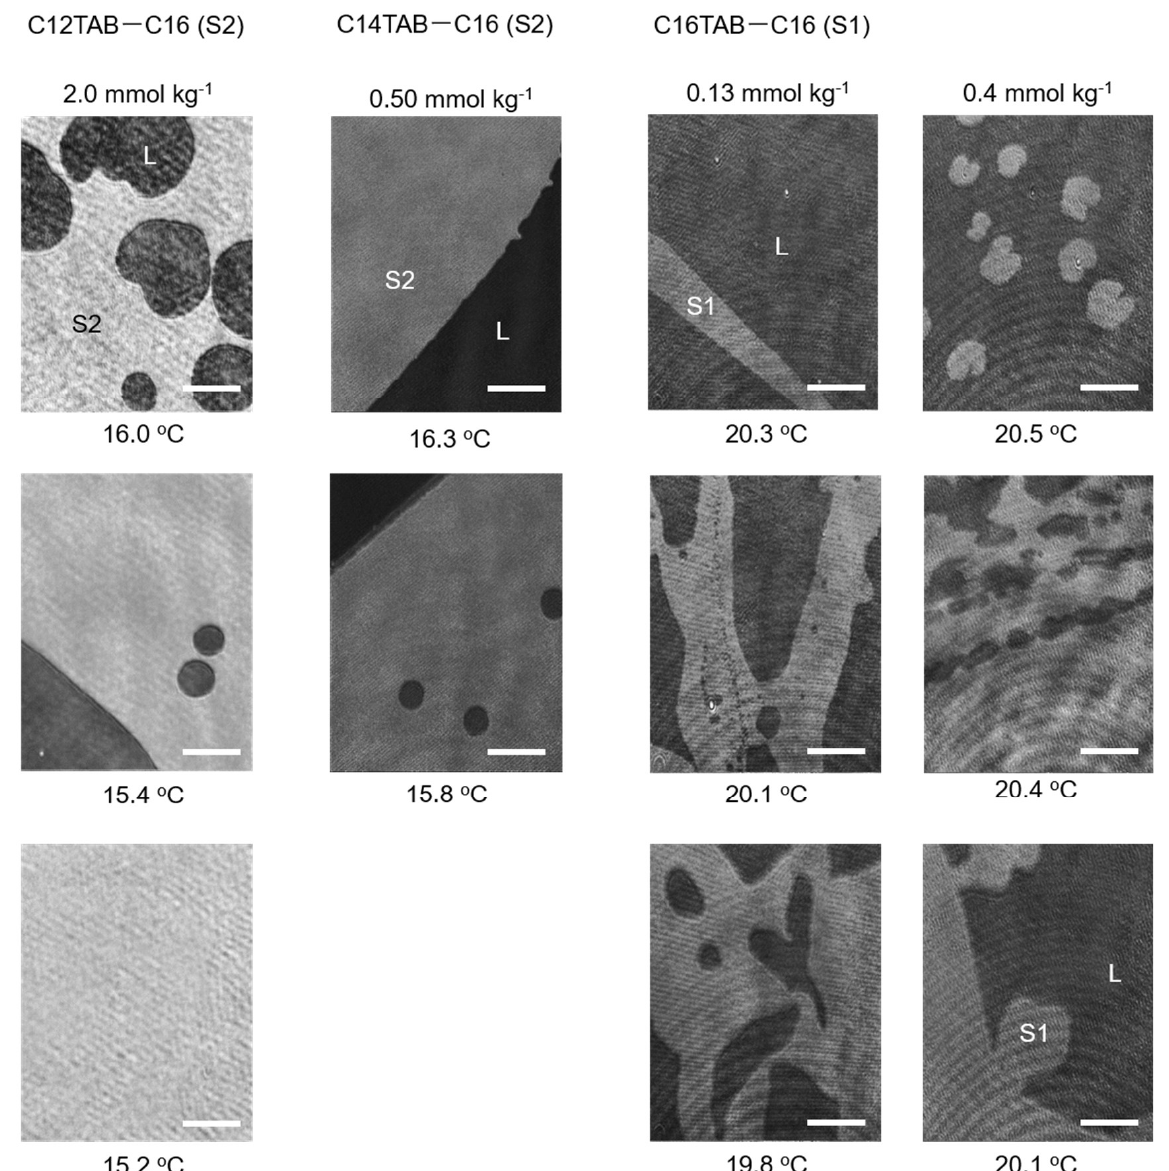
Figure 4. BAM images of nucleated S2 domains for the C12TAB − C16 system (left column) and those for the C14TAB − C16 system (second column from left). The right two columns show BAM images of S1 domains taken for the C16TAB − C16 system. Images for the C14TAB − C16 system were reproduced from Ref. [22] with permission (H. Matsubara et al., J. Phys. Chem. Lett . 2013 , 4 , 844–848. Copyright 2013 American Chemical Society).